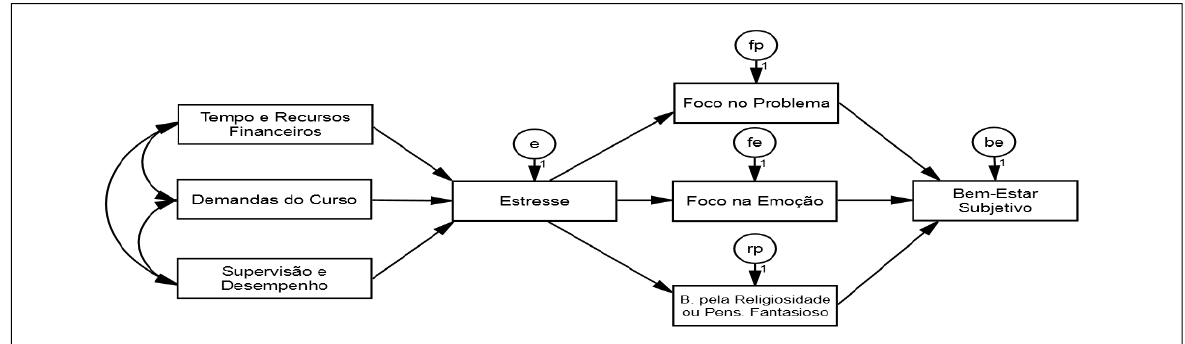
Figura 1 . Modelo Inicial do Bem-Estar Subjetivo de Mestrandos e Doutorandos na Pós-Graduação.